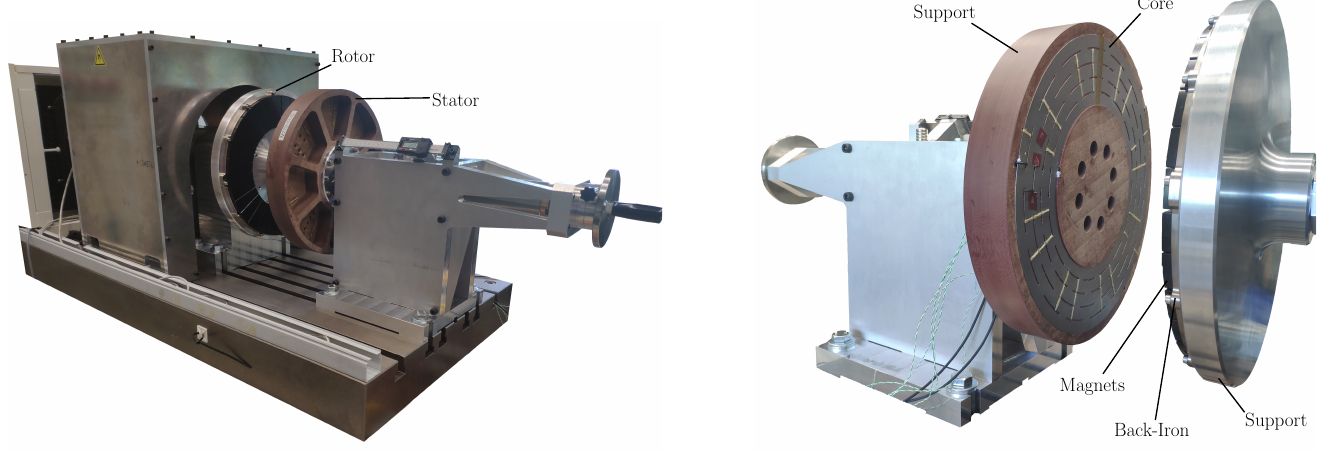
Figure 10. AFPM experimental setup from EPE